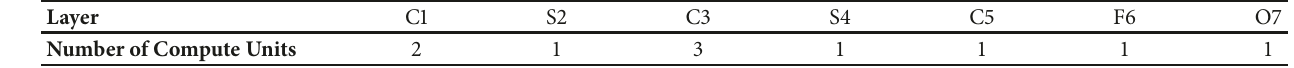
Table 7: The assignments of compute units.